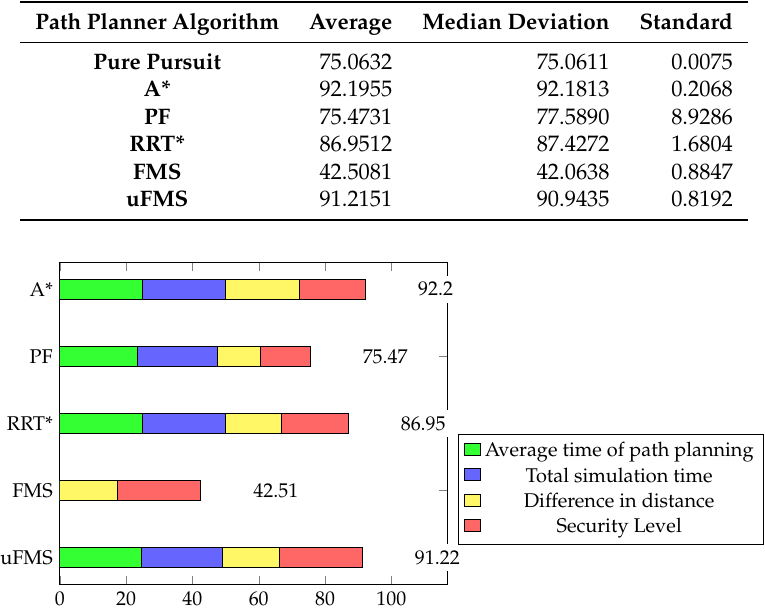
Figure 14. A* complete solution.